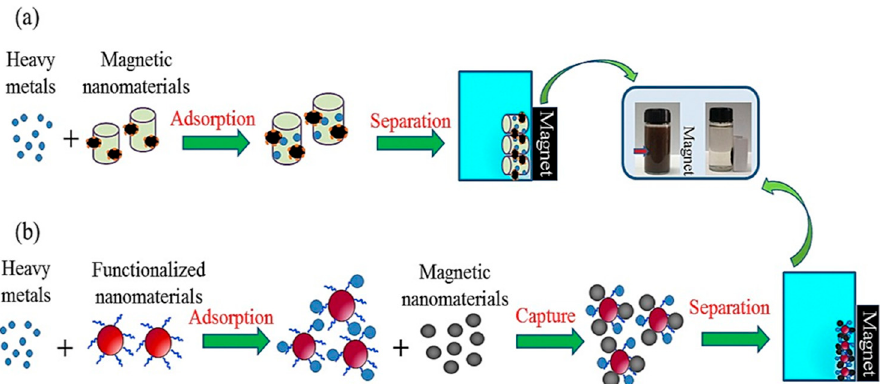
Figure 12. Here we have given a schematic diagram of how magnetic carbon-based nanomaterials Figure 12. A schematic diagram showing heavy metal absorption and separation using ( a ) mag- can be used to retrieve magnetic nanomaterials and capture magnetic nanoparticles (NPs). ( a ) re- netic nanoparticles ( b ) magnetic carbon-based nanomaterials used in heavy metal separation and nanoparticle retrieval. Reprinted with permission from [122]. 2018,